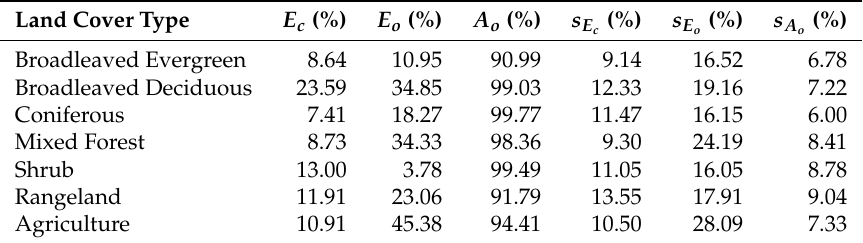
Table 7. Information of site validation